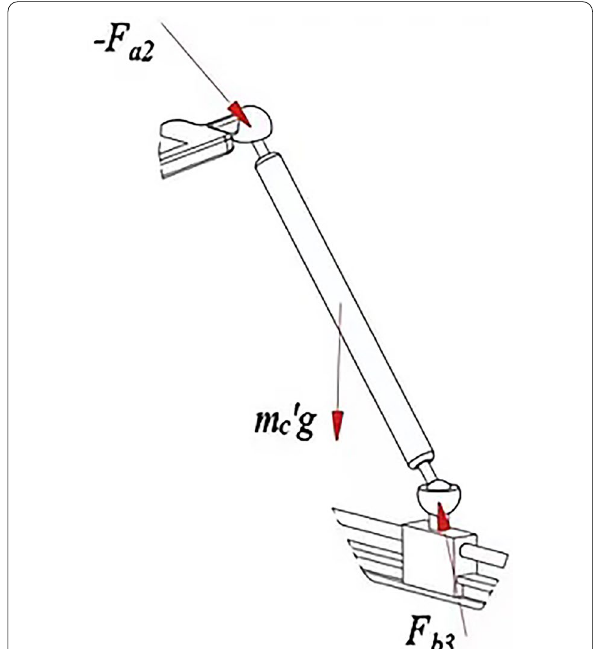
Figure 7 Force analysis diagram of -S-S- Link